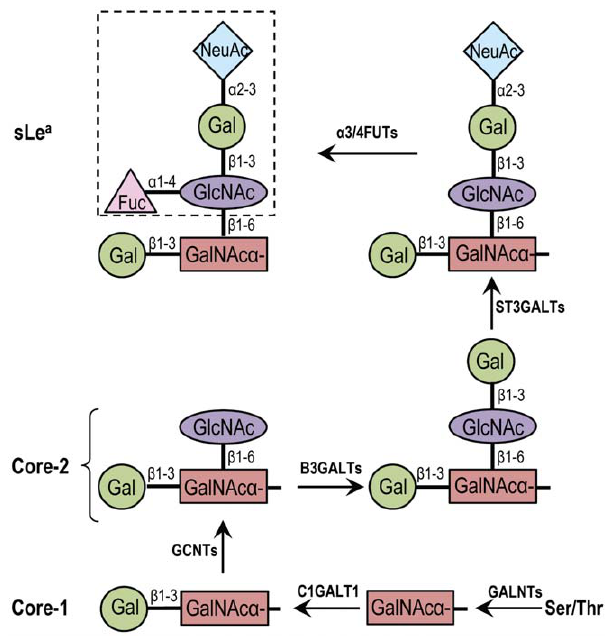
Figure 1. Biosynthetic pathway of nucin core 2-associated sialyl Lewis a (sLe a ) antigen. Biosynthesis of mucin O-glycans is initiated by the addition of GalNAc to ser or thr of the peptide as catalyzed by polypeptide N-acetylgalactosaminyltransferases (GALNTs). This is followed by the addition of Gal in b 1-3 linkage to GalNAc as catalyzed by C1GALT1 enzyme and produces core-1. Core 2 is generated by adding GlcNAc in b 1-6 linkage to GalNAc by GCNTs. To synthesize sLe a , Gal is transferred to GlcNAc in b 1-3 linkage to form type 1 chain as catalyzed by B3GALTs, followed by the addition of a 2- 3NeuAc to Gal as catalyzed by ST3GALTs and then a 4-fucose (Fuc) to GlcNAc as catalyzed by a 3/4FUTs.